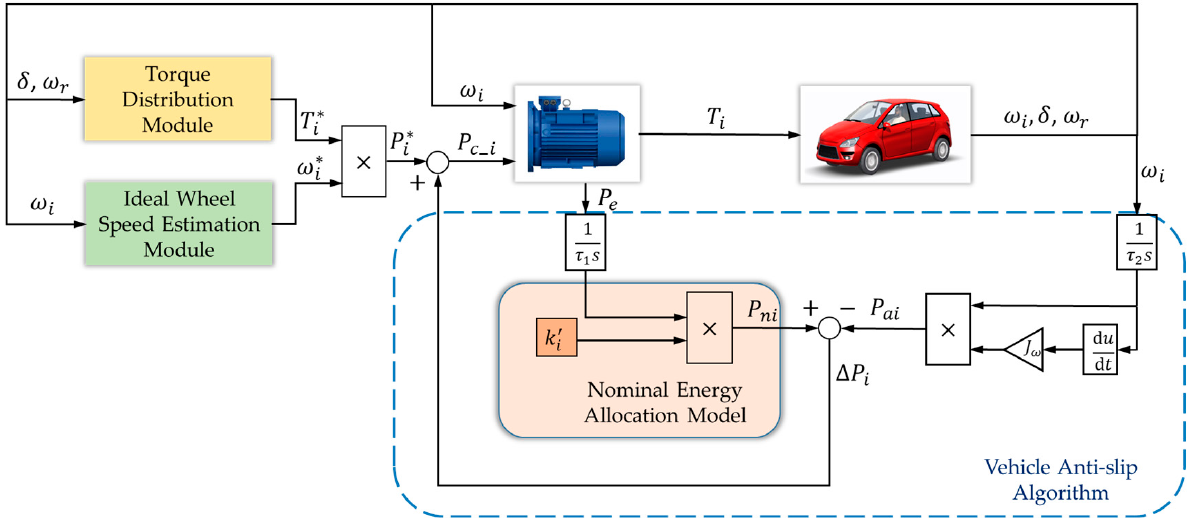
Figure 2. Control system based on energy method.